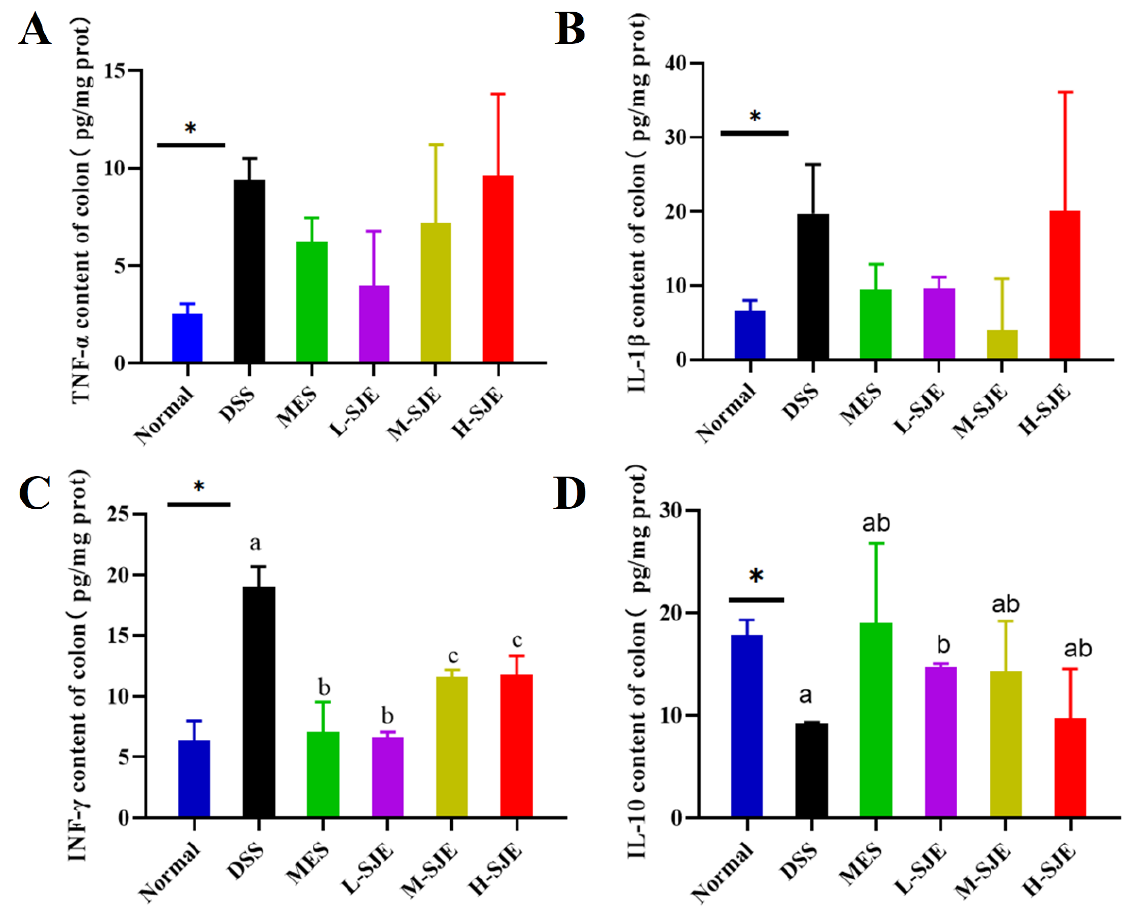
Figure 4. Effects of SJE on inflammatory responses in the colon of DSS-induced colitis mice. The levels of TNF- α ( A ), IL-1 β ( B ), INF- γ ( C ) and IL-10 ( D ). * p < 0.05 means statistically significant. Different superscript letters (a–c) in the same graph indicate significant differences between groups ( p < 0.05).